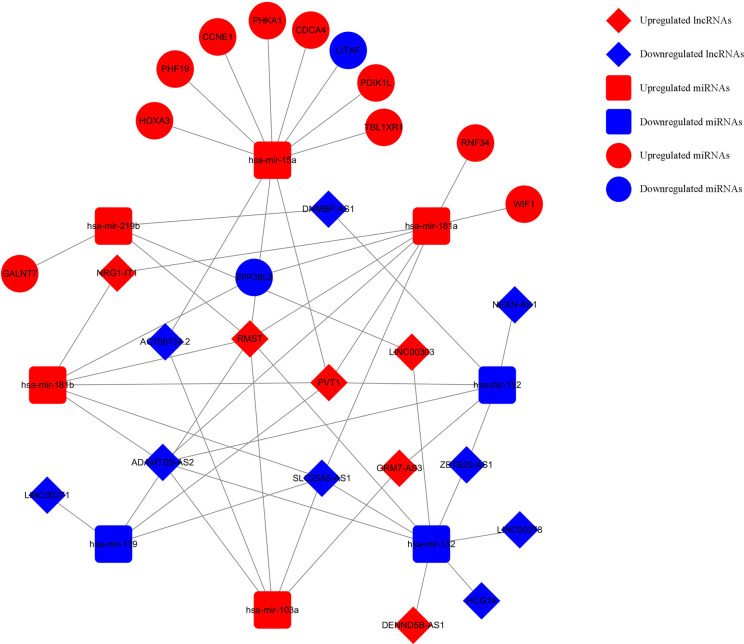
Survival-related ceRNA network in WT. The red diamonds indicate upregulated lncRNAs, and blue diamonds indicate downregulated lncRNAs. The red rectangles indicate upregulated miRNAs, and blue rectangles indicate downregulated miRNAs. The red circles diamonds indicate upregulated mRNAs, and blue circles diamonds indicate downregulated mRNAs.